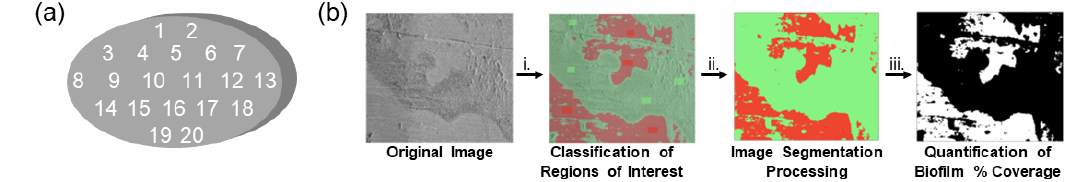
Figure 3. SEM analysis showing (a) a schematic diagram depicting the regions of interest used in the SEM image analysis of the implants and (b) an SEM image processing using the automated Trainable Weka Segmentation approach: (i) selection of training samples to classify regions of interest – biofilm-free surface (red) and biofilm-covered surface (green); (ii) image segmentation processing; and (iii) quantification of the percent biofilm coverage.